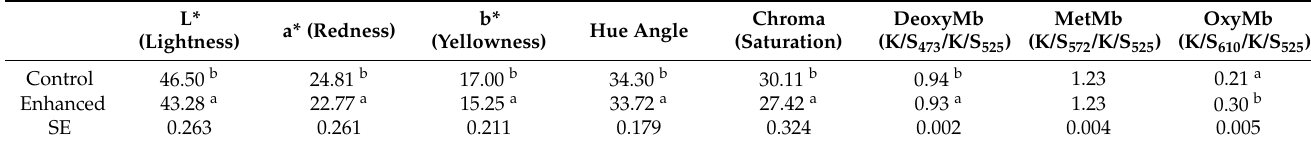
Table 3. Effects of brine-enhancement on instrumental color parameters and surface myoglobin forms of Nellore Longissimus lumborum steaks packaged in HiOx-MAP.